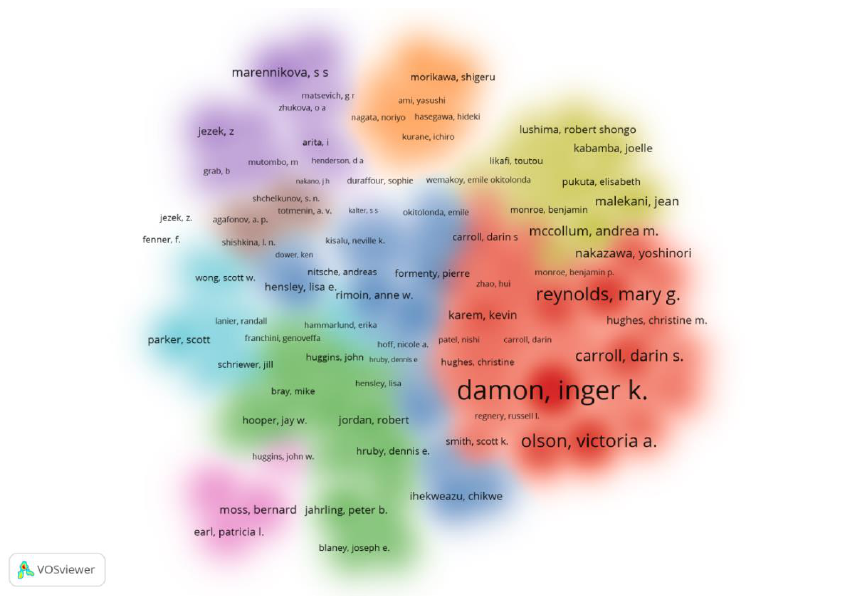
Figure 2 (c). The density map of terms in MPX research